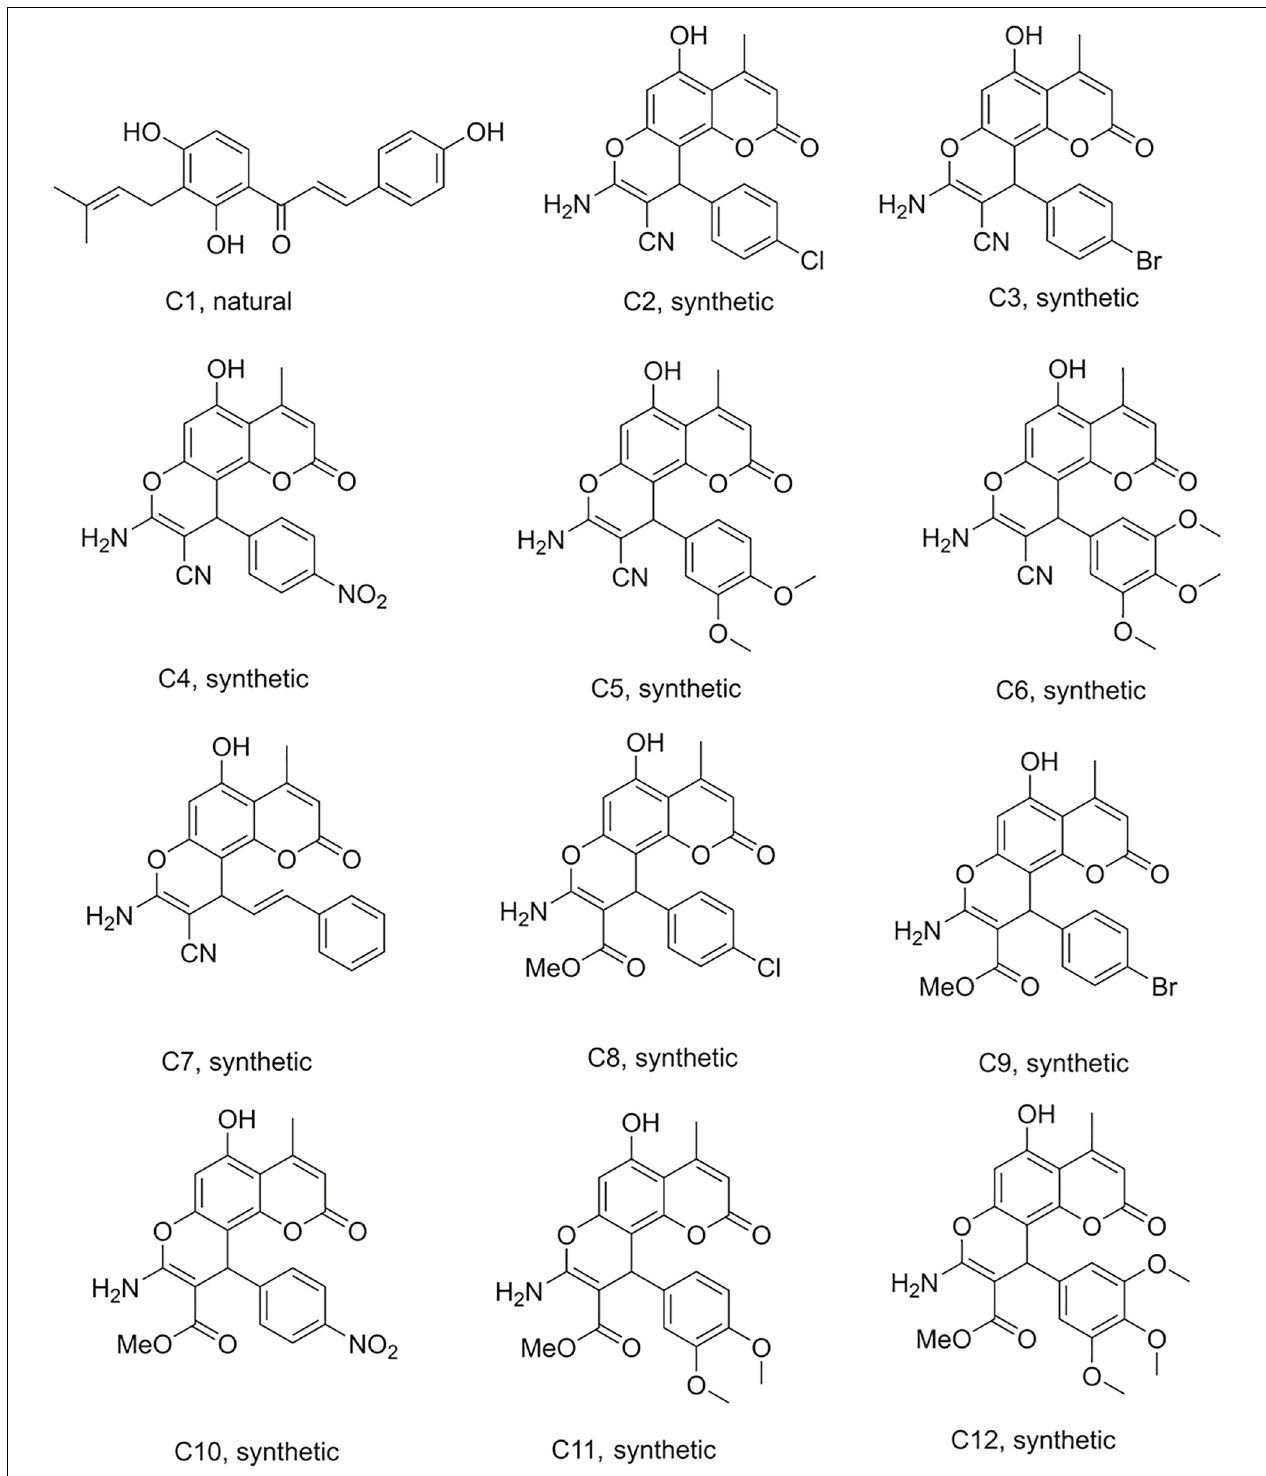
FIGURE 1 | Structures of the compounds tested for anti- M. tuberculosis activity: Chalcone C1, and the pyranocoumarins C2–C12 (Abegaz et al., 1998; Martin et al., 2018).